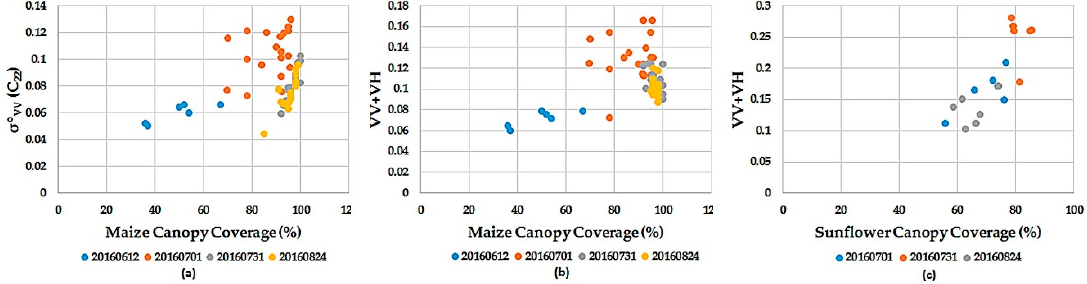
Figure 11. Correlation between σ⁰ VV ( a ), and VV + VH ( b ), backscatter values of maize, and VV + VH ( c ) backscatter value of sunflower with their CC during growing stages.